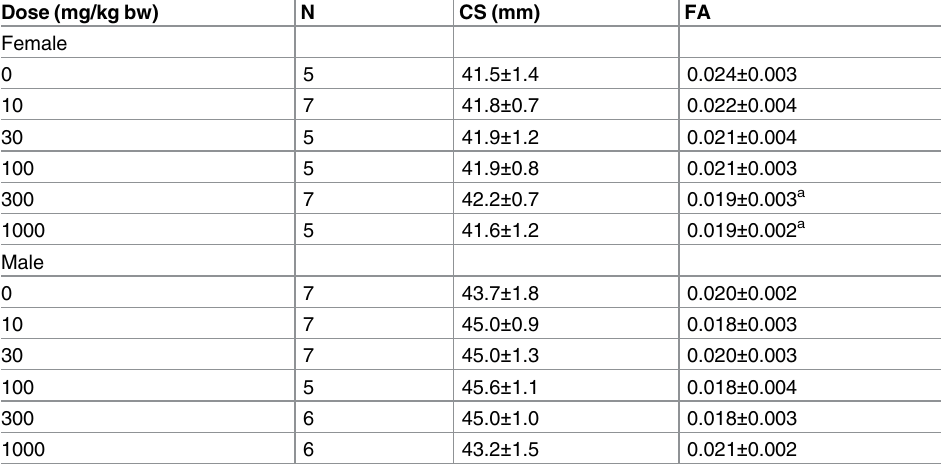
Table 2. Centroid size (mean ± SD, mm) and fluctuating asymmetry (mean ± SD) for craniofacial land- marksin female and male offspring on PND 84 by total dose of PBC 180.